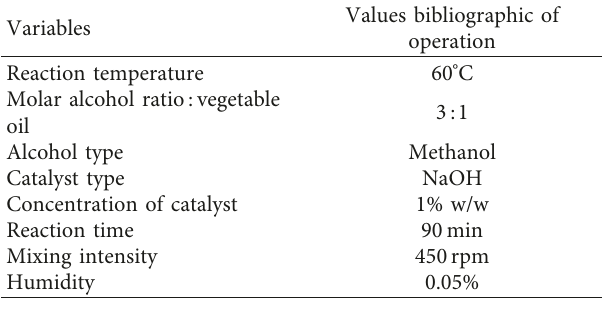
Table 2: Identified variables and specific operation values.